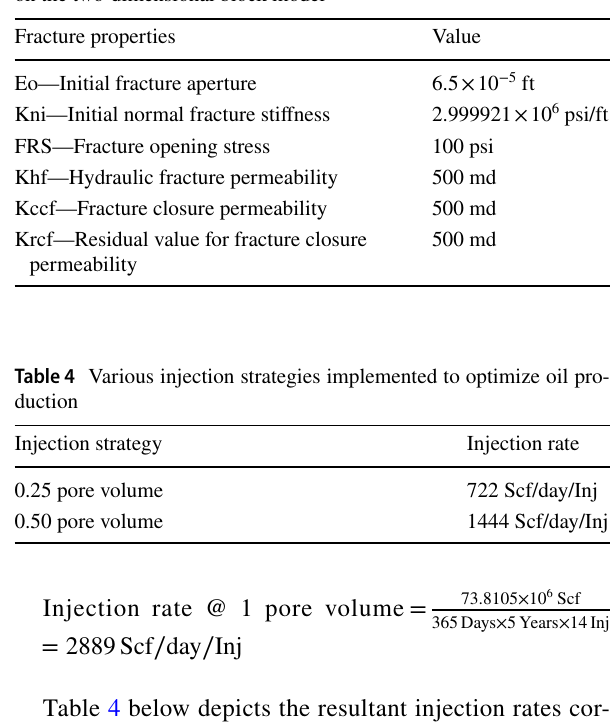
Table 4 below depicts the resultant injection rates cor- responding to each pore volume injection strategy. These